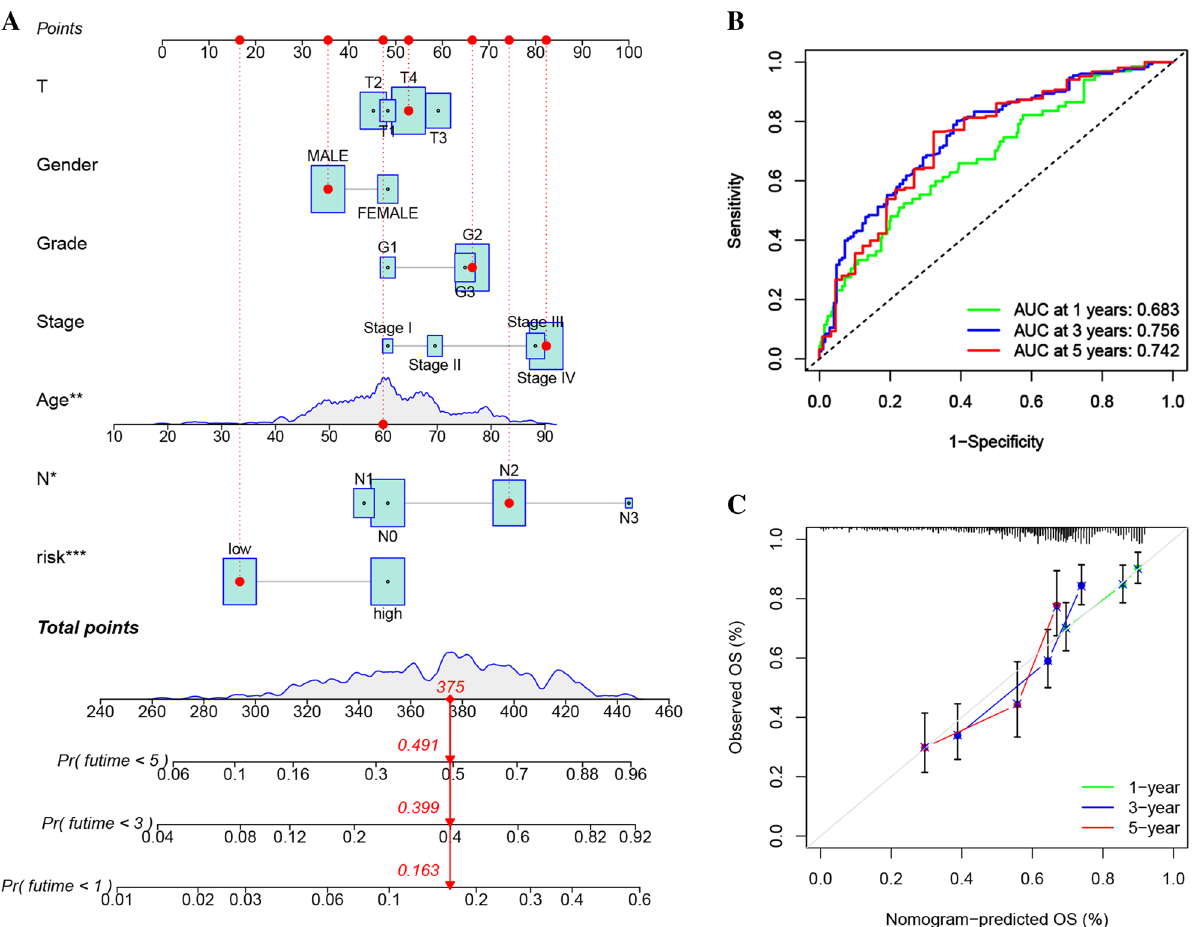
Figure 5. ( A ) A prognostic nomogram for HNSCC patients. ( B ) ROC curves showing the capability of the nomogram in predicting OS over one, three, and five years. ( C ) Calibration plot of the nomogram in forecasting the OS over one-, three- and